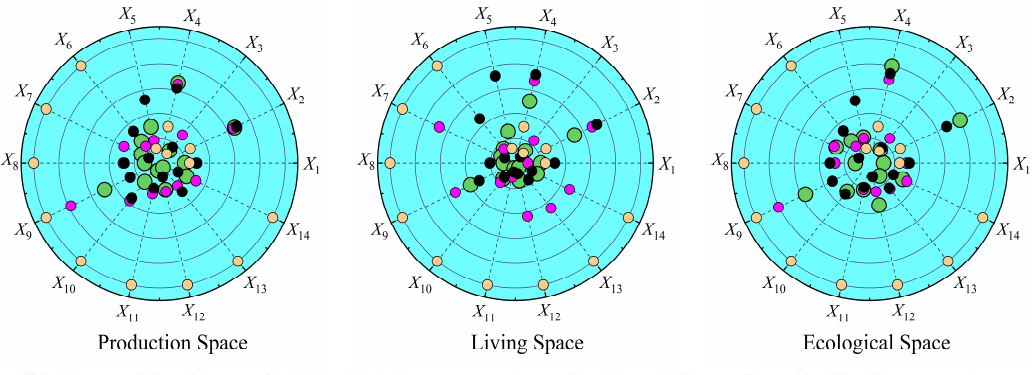
Figure 14. The q-mean value of the driving factors of spatial change in the Yangtze River Economic Belt from 2000 to 2020.